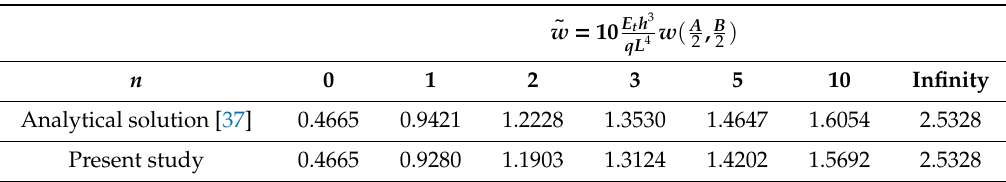
Table 1. Comparison of the FEM results with analytical solutions [37] for a simply supported square plate ( L × L , h / L = 1 / 10 ) with uniformly distributed load q. Material model (Equation (33)), E t = 380 GPa , E b = 70 GPa .